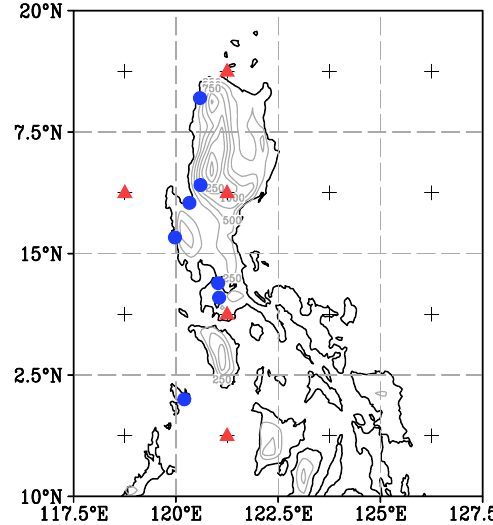
Figure 1. Location of the seven meteorological stations of the Philippine Atmospheric, Geophysical and Astronomical Services Administration (PAGASA; blue circles), Climate Prediction Center Merged Precipitation Analysis (CMAP) grid points (+ markings), and the topography of the Philippines above 250 m (grey contour lines). The contour interval of the topography is 250 m. The red triangles indicate the nearest five CMAP grid points to the location of the PAGASA stations. Daily data of zonal ( U ) and meridional ( V ) components of winds, geopotential height ( HGT ), vertical velocity ( ω ), and relative humidity ( RH ) at multiple levels from the National Centers for Environmental Prediction-Department of Energy (NCEP-DOE) Atmospheric Model Intercomparison